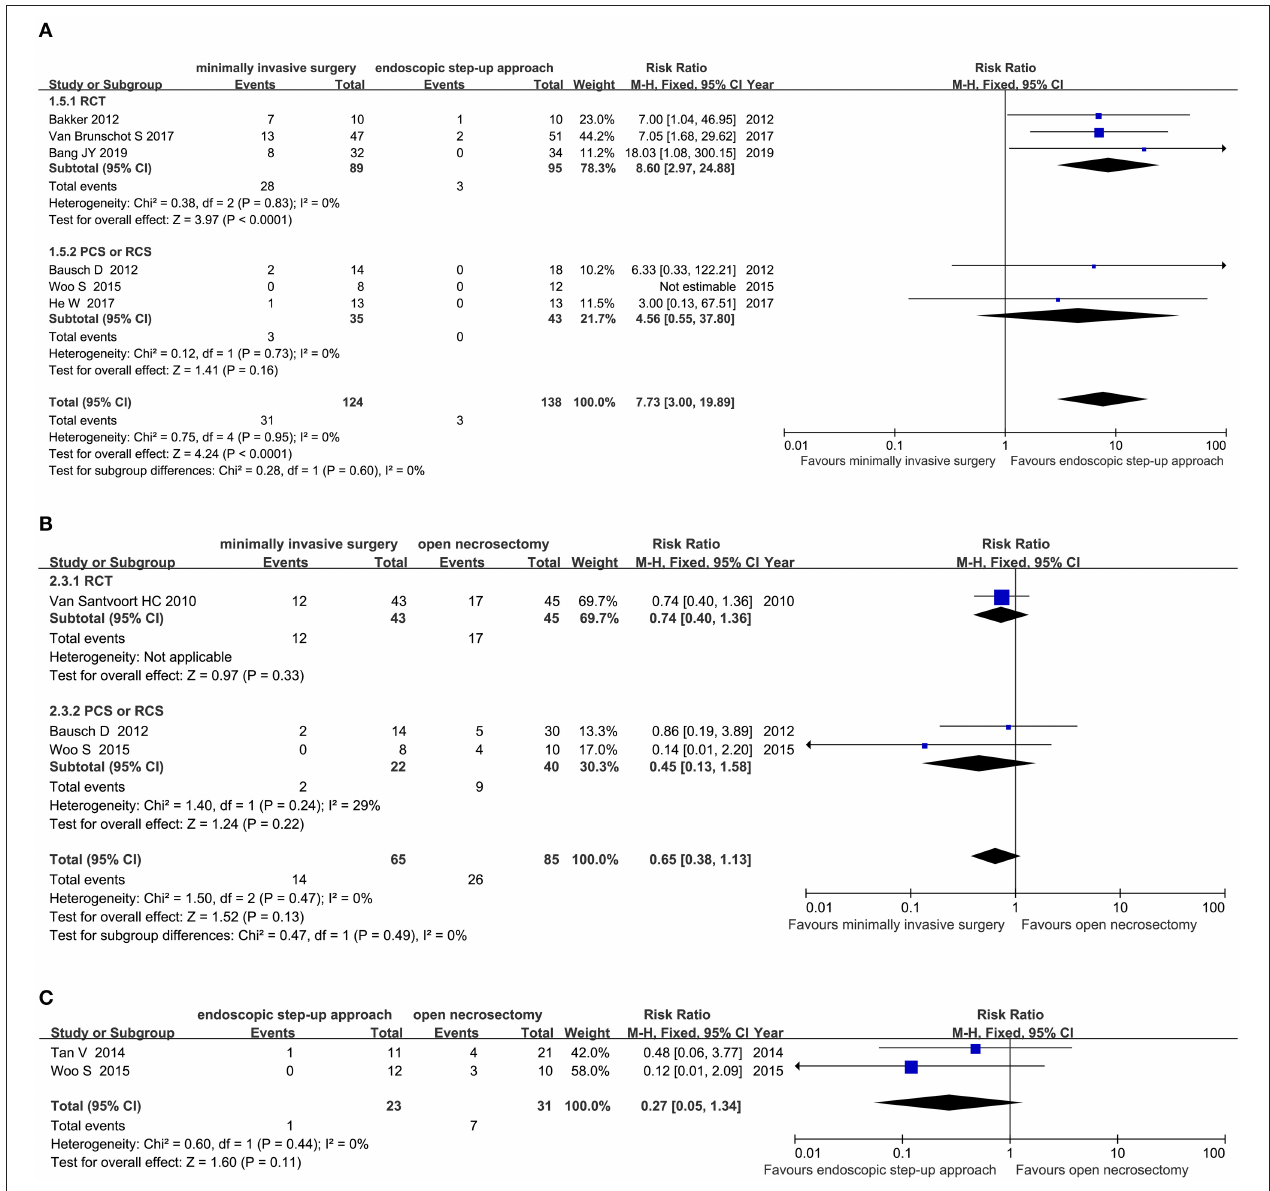
FIGURE 7 | Forest plots for the incidence of pancreatic fistulas. (A) Between minimally invasive surgery and endoscopic step-up approach. (B) Between minimally invasive surgery and open necrosectomy. (C) Between endoscopic step-up approach and open necrosectomy M-H, Mantel–Haenszel test; Fixed, a fixed effects model; CI, confidence